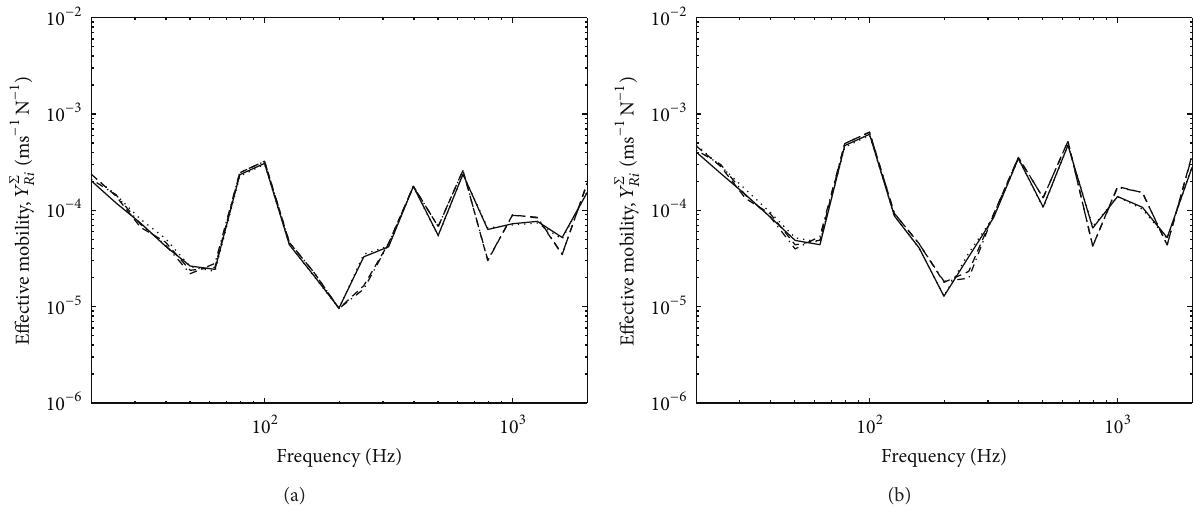
Figure 13: Effective mobility of the thick plate by assuming (a) zero phase and (b) random phase.